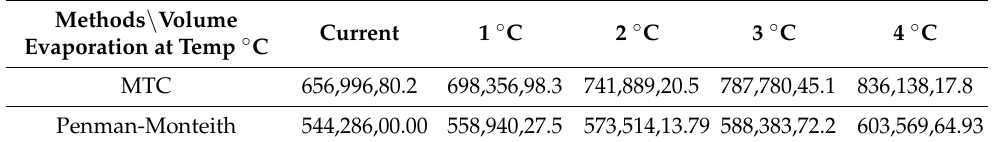
Table 4. Evolution of the volumes (m 3 ) of water exchanged with the atmosphere by evaporation according to the IPCC scenarios on all of the water bodies of the Brenne